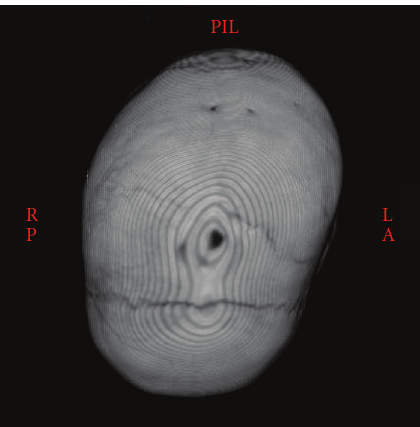
Figure 1: Three-dimensional CT showing the synostotic sagittal suture with a posteriorly twisted skull.